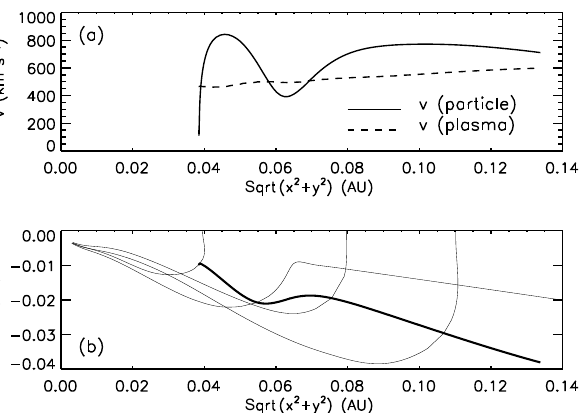
Figure 8. (a) The particle and plasma speed and (b) the magnetic field structure along the trajectory of a rapidly escaping particle with Q/m = 10 − 5 e/m p . The thin lines in panel (b) are the selected magnetic field lines encountered by the particle along its trajectory, which is shown as the thick line. The coordinate z is measured along the solar rotation axis with z = 0 at the solar equator.